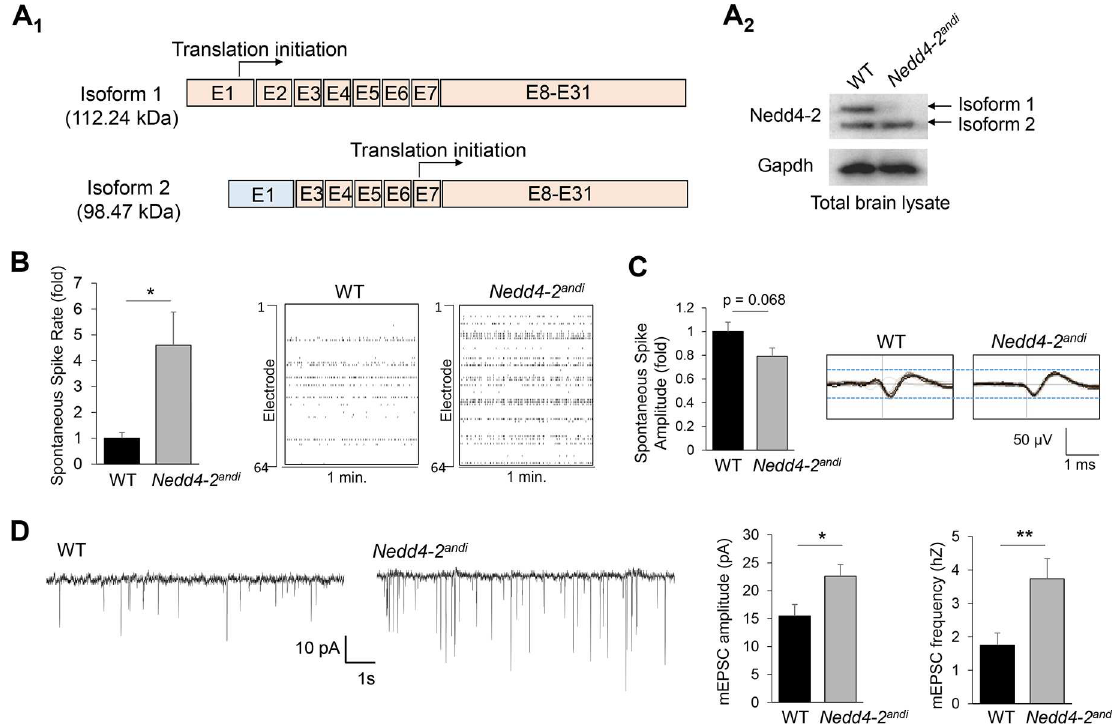
Fig 1. Nedd4-2 mediates spontaneous neuronal and synaptic activity. ( A 1 ) A diagram showingtwo alternativeprotein products (isoforms 1 and 2) from the Nedd4-2 gene, and ( A 2 ) western blot results of Nedd4-2and Gapdh from brain lysates of WT or Nedd4-2 andi mice at age 4-weeks old. ( B ) Quantificationof spontaneous spike rate (left) and representative raster plots of spontaneous spikes from 1-min recording(right) of WT or Nedd4-2 andi cortical neuroncultures at DIV 13–14. ( C ) Quantification of averagespontaneous spike amplitude(left) and representative averagetraces of 1-min recording(right) of WT or Nedd4-2 andi cortical neuroncultures at DIV 13–14.The black lines represent the averageof all the spikes within representative 1-min recordings. ( D ) Patch-clamp recordingfrom WT or Nedd4-2 andi cortical neuronsat DIV 14. Representative mEPSC traces and quantification of mEPSC amplitudeand frequency are shown (n = 15 for both WT or Nedd4-2 andi neurons). Data are analyzedby Student’s t -test and representedas mean ± SEM with * p < 0.05, ** p < 0.01.